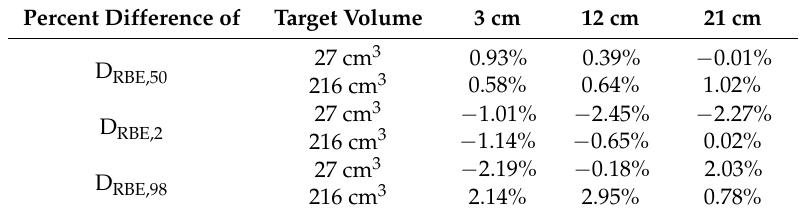
Table 2. Percent D RBE difference comparison for Local Effect Model (LEM) D RBE VH between FRoG and MC for 12 C ions.